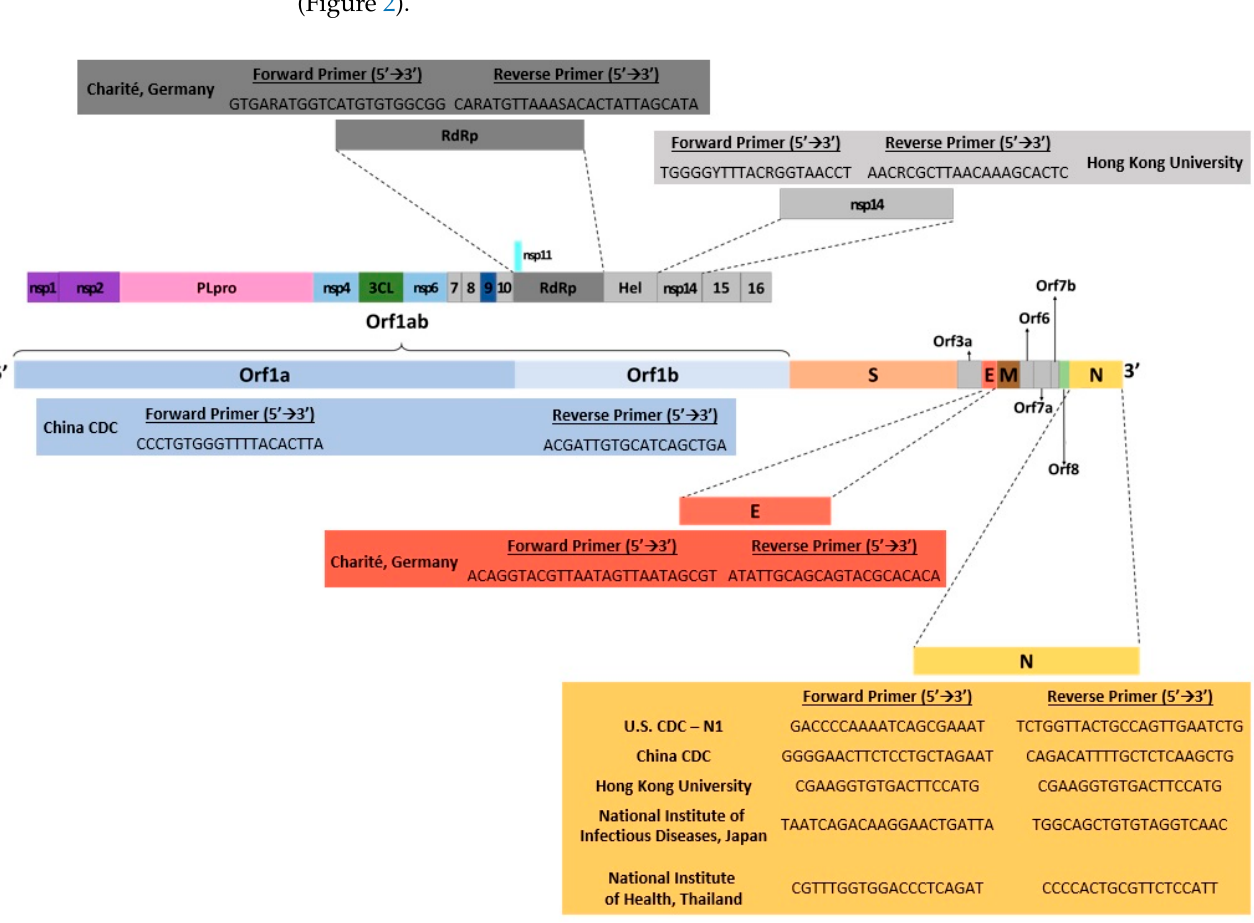
Figure 2. Illustration of SARS-CoV-2 genomic map with gene targets of diagnostic RT-PCR tests and their corresponding 5 ′ → 3 ′ forward/reverse primers. Data were obtained from several published reports [6,19–22,24].